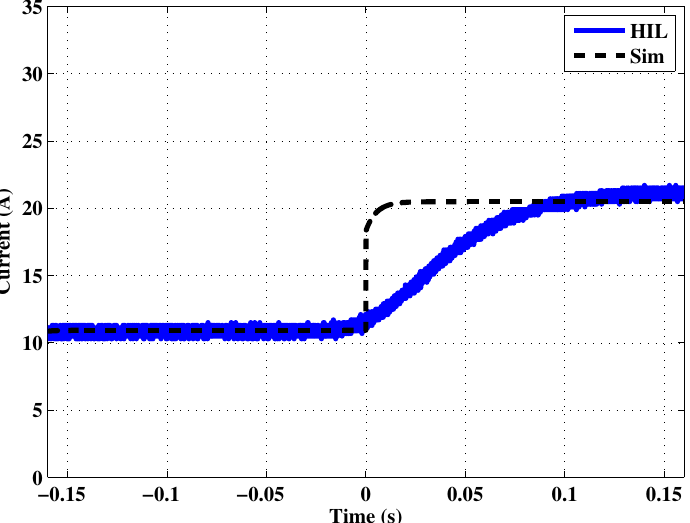
Figure 11. Simulation and hardware-in-the-loop results for Source 1 current during a step change in wind